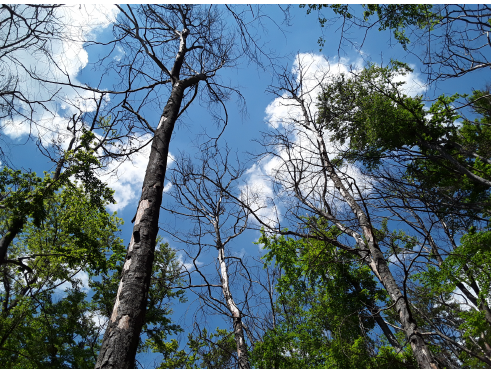
Figure 2. Photo documentation of tree mortality of European beech ( Fagus sylvatica ) on the Burgberg during the field survey at Hainich National Park. The photograph was taken by the author on 2 June 2021.